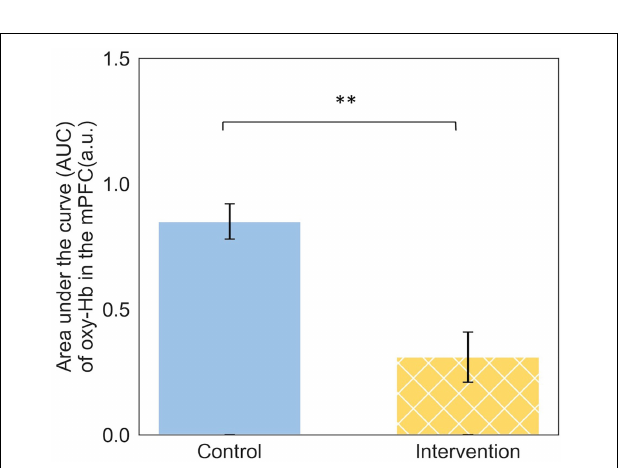
FIGURE 6 | Neuro-cognitive activation in the mPFC when engineering students made their final recommendation for green infrastructure, ∗∗ p < 0.05.